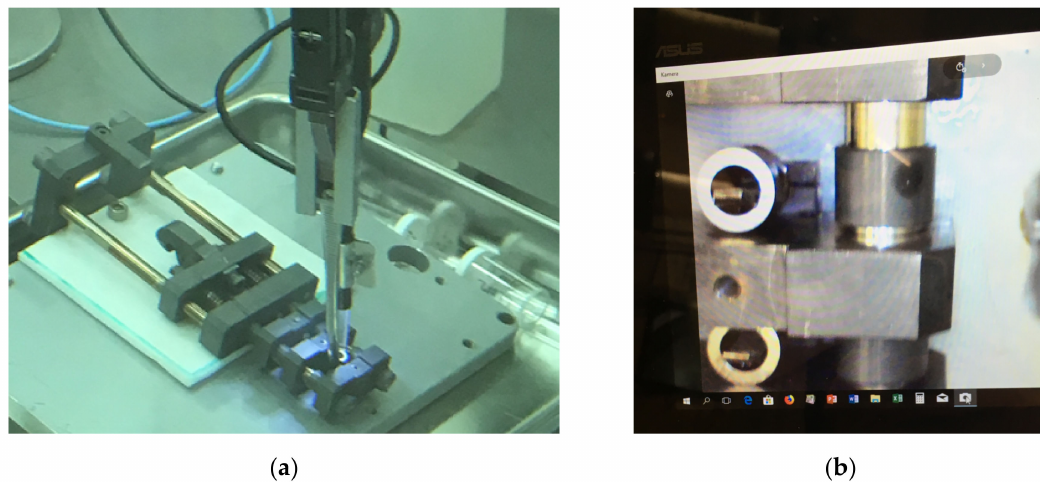
Figure 10. ( a ) The rig for loading radioactive specimens is placed on a backing plate with pegs for locking the loading bars open. Tweezers held in hot cell manipulators with an integrated camera facilitate accurate placement of the O-ring specimens in the rig ( b ) camera view on PC outside of hot